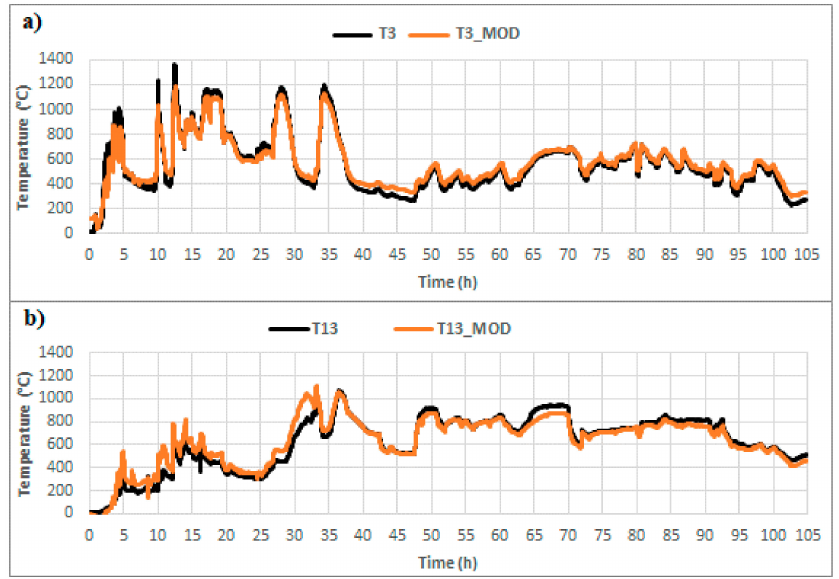
Figure 20. The measured (T) and modeled (T_MOD) temperature behavior, ( a ) temperature T 3 , ( b ) temperature T 13 (Source: own